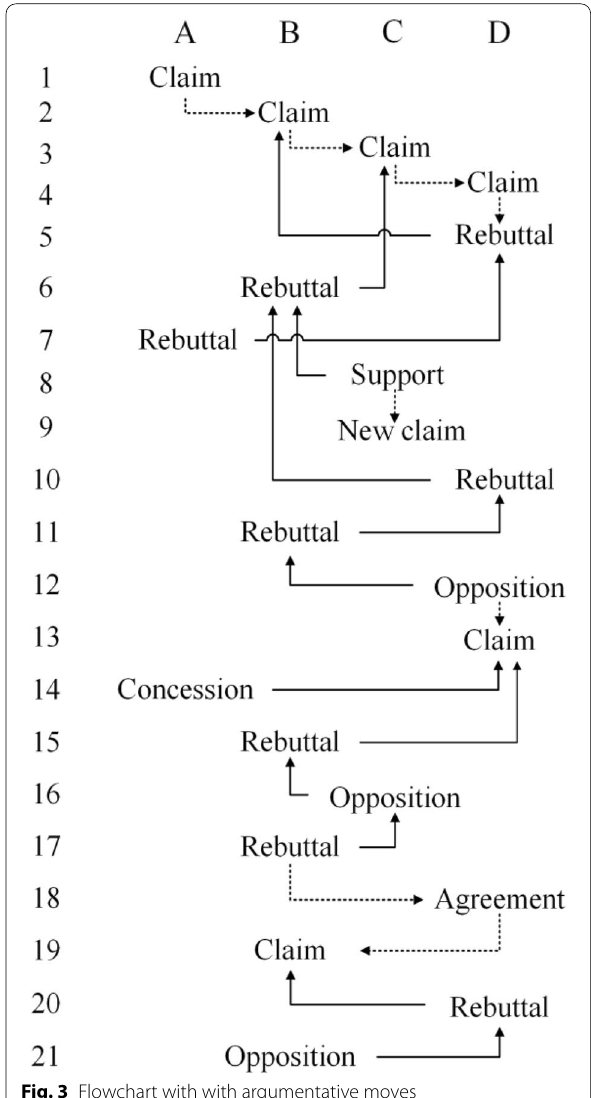
Fig. 3 Flowchart with with argumentative moves